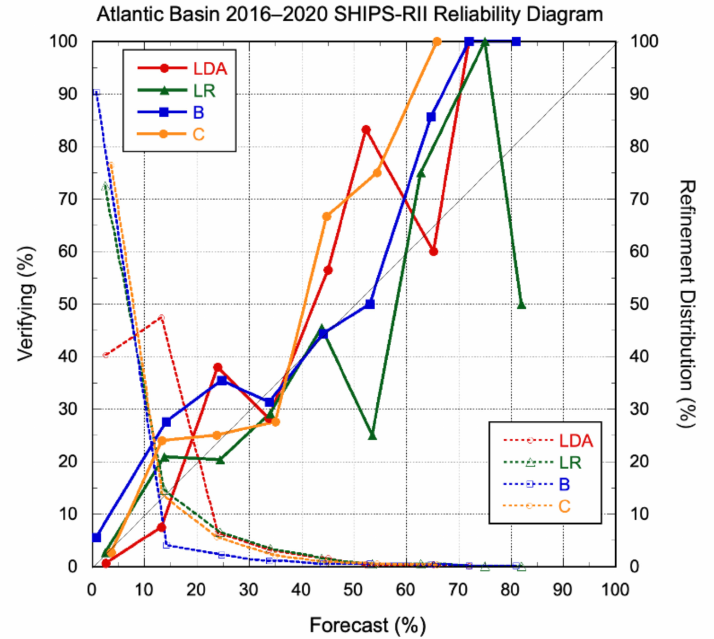
Figure 6. Atlantic basin 2016–2020 reliability diagram for the SHIPS-RII-LDA (red), SHIPS-RII-LR (green), SHIPS-RII-B (blue), and SHIPS-RII-C (orange) for the RI threshold of 30 kt/24 h. Perfect reliability is indicated by the sloping thin black line. The refinement distributions are given by the dashed